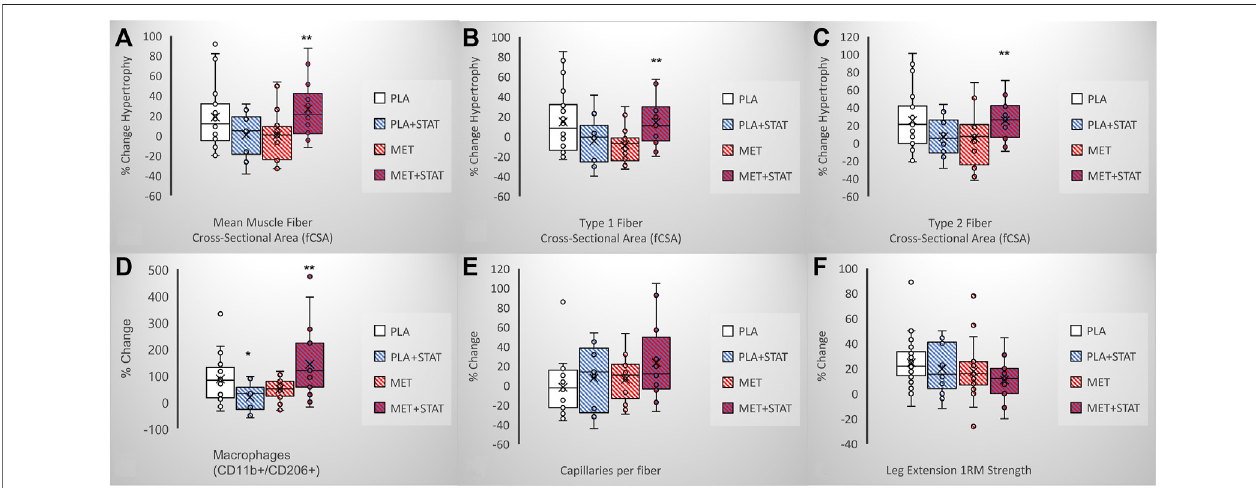
FIGURE 2 | Statin effects on PRT outcomes with and without combined metformin. Box and whisker plots show (A – C) mean and fi ber type-sspeci fi c growth and (D,E) macrophage and capillary change differences between monotherapy versus combined metformin/stain use only (PLA + STAT, n = 10) does not affect mean fi ber growth compared to placebo (PLA, n = 22), but combined metformin/stain therapy (MET + STAT, n = 14) signi fi cantly response when compared to metformin monotheraphy(MET,n-16)possiblyduetosigini fi cantlyincreasedmacrophagesorincreasedcapillarydensity( p =0.09).Boxandwhiskerplots (F) showthatstatin use only (PLA + STAT, n = 13) does not affect functional gains inleg extension strenght when compared to placebo (PLA, n = 31), but combined metformin/staintherapy (MET + STAT, n = 16) does not rescuse reduced strenght gains when compared to metformin monotherapy (MET, n-28) ANCOVA (adjusted for sex and stain use for muscle size and function, and sex, stain use, and anti-in fl ammatory medications for immune cells) p -values are shown.* denotes signi fi cance from placebo group,** denotes sigin fi cance from metformin group.